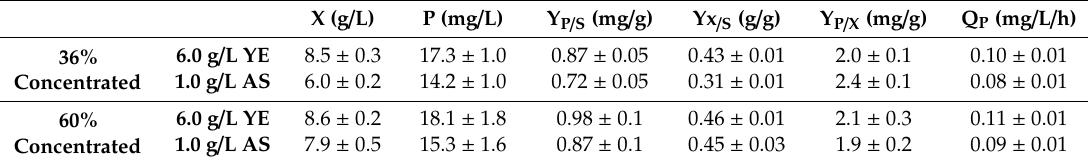
Table 4. Biomass and astaxanthin output following P . cultivation in non-detoxified stillage media with increased nitrogen or nutrient loadings.